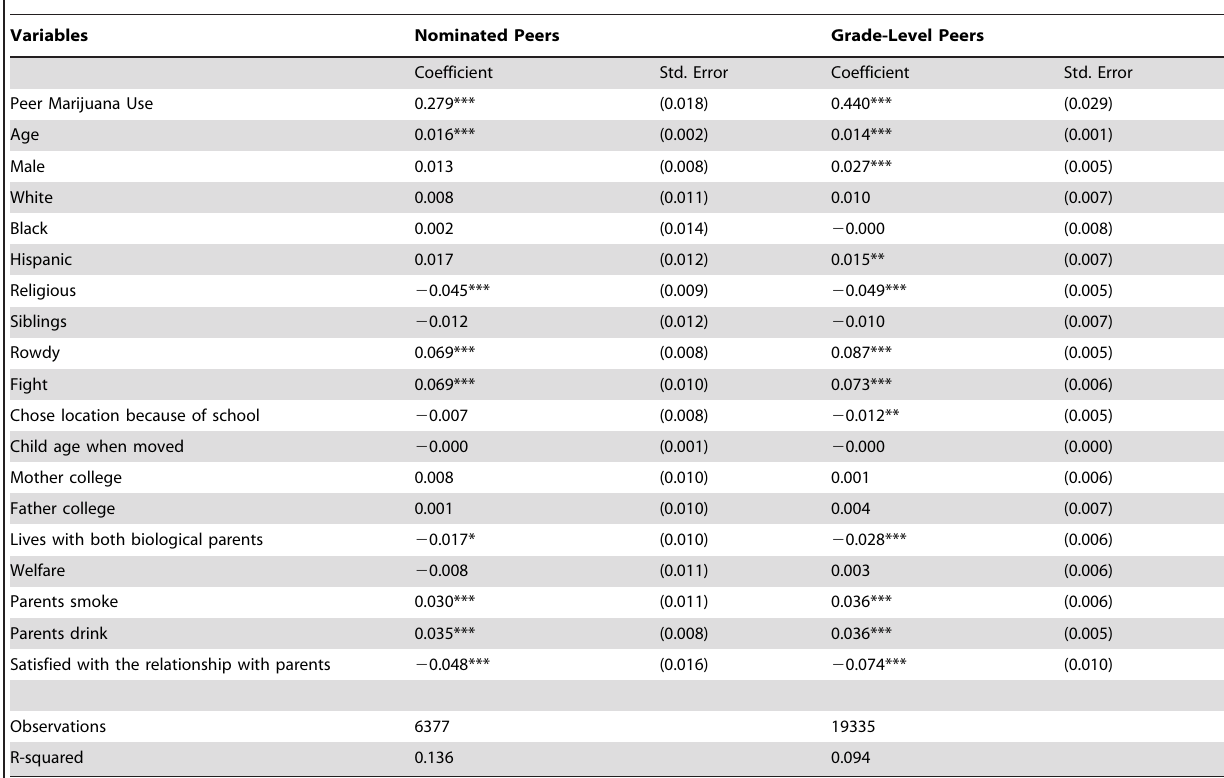
Table 2. Determinants of marijuana use